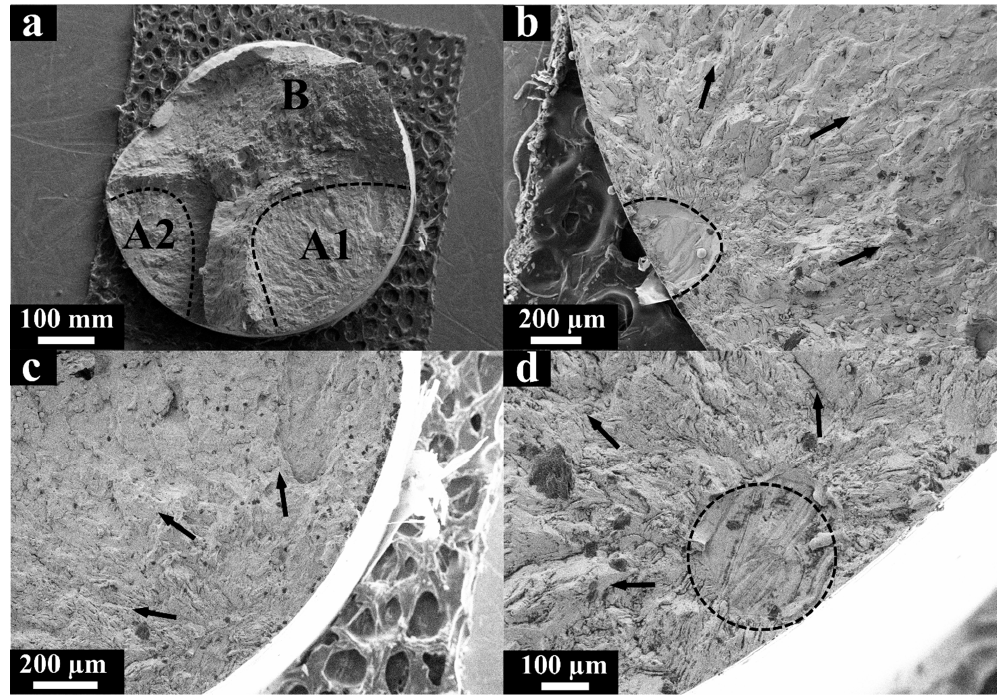
Figure 5. SEM micrographs of the fracture surface of the LPBF specimen after loading in the HCF regime ( σ max = 450 MPa and N = 2.23 × 10 5 cycles), ( a ) zones of failure; ( b ) direction of crack propagation (zone A2); ( c ) the direction of crack propagation (zone A1); ( d ) the site of crack initiation (zone A1).